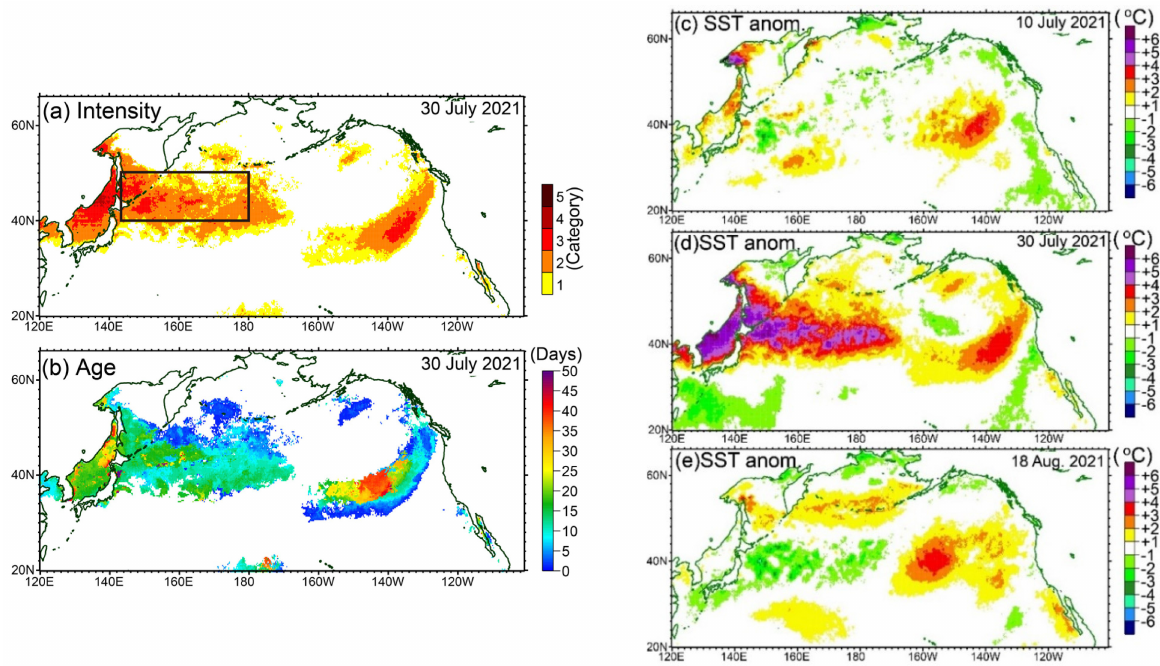
Figure 1. ( a ) Intensity and ( b ) age of marine heatwaves (MHWs) on 30 July 2021. In ( a ), the rectangle indicates the area within 143 ◦ E–180 ◦ and 40 ◦ –50 ◦ N, the focal area of our analysis. SST anomalies are shown on ( c ) 10 July, ( d ) 30 July, and ( e ) 18 August